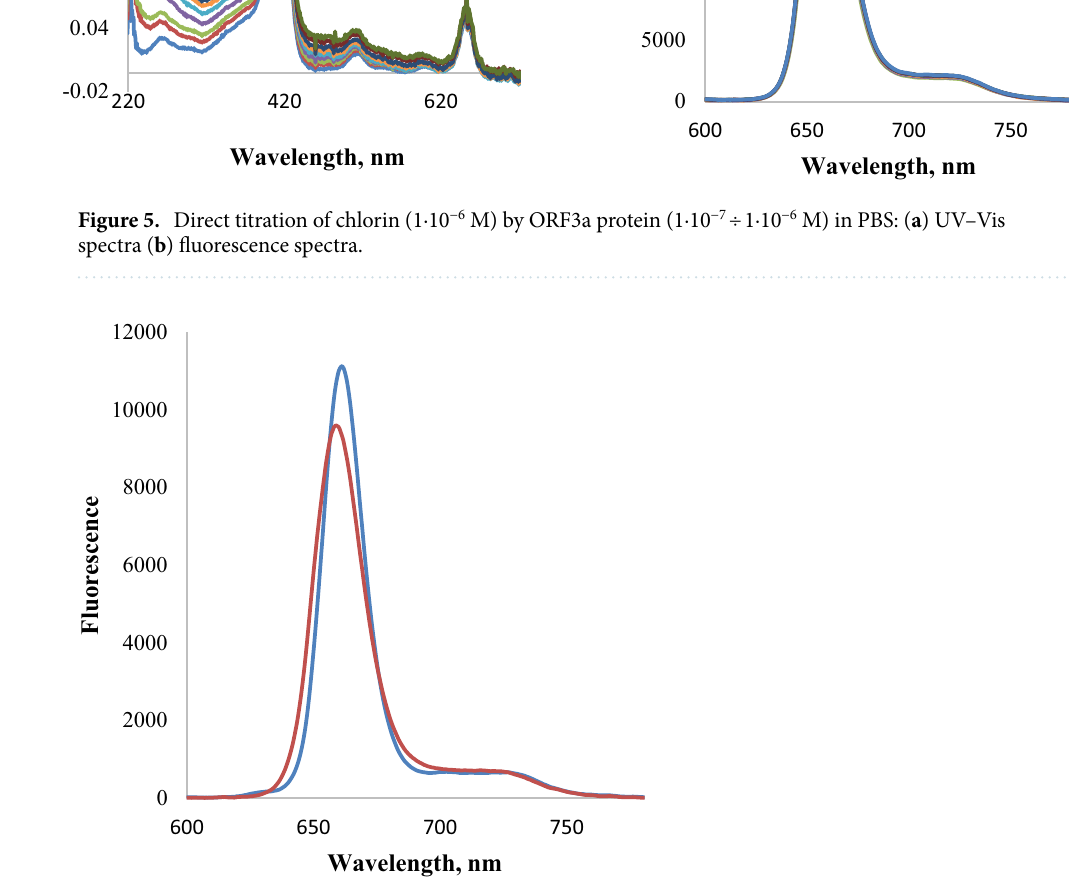
Figure 6. Chlorin fluorescence spectra in DMF (blue line) and PBS (orange